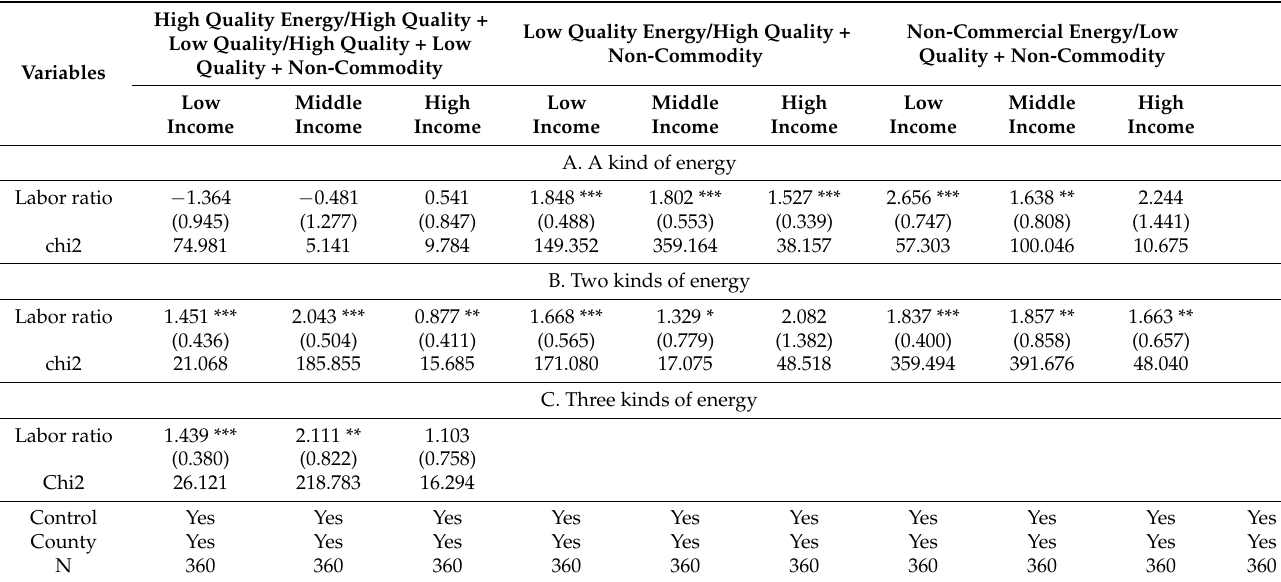
Table 4. Heterogeneity analysis results: Annual household cash